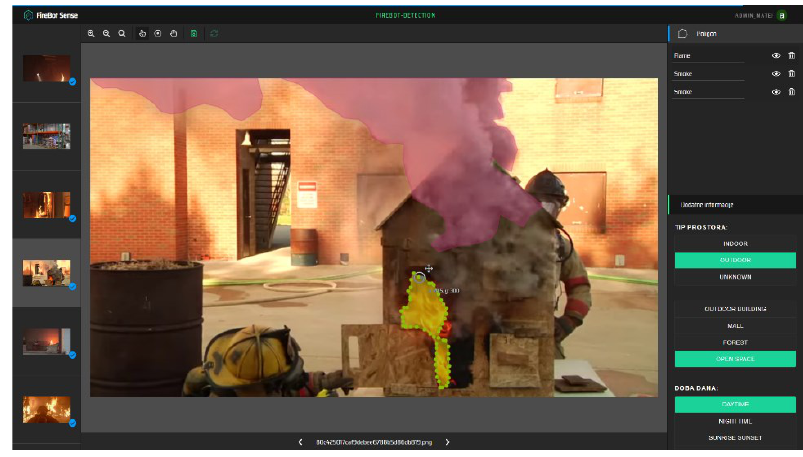
Figure 12. FireSense image-annotation tool interface.